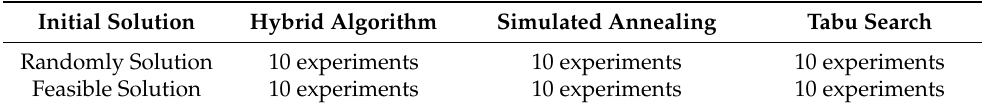
Table 5. Experiment design for experiment